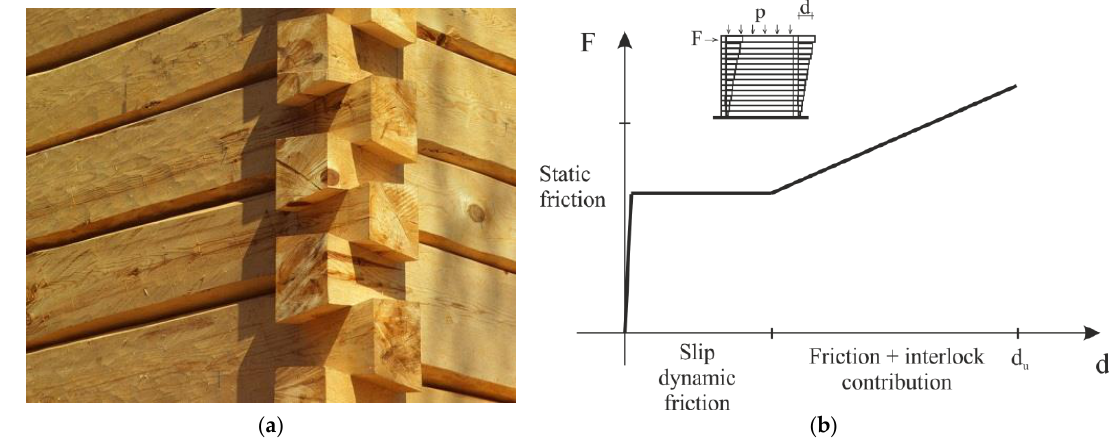
Figure 2. Typical examples of ( a ) corner joint features and ( b ) in-plane lateral response for timber Blockhaus shear-walls under monotonic loads (figure reproduced from [21] with permission from Elsevier® , Copyright License Agreement n. 4681430084070, October 2019).